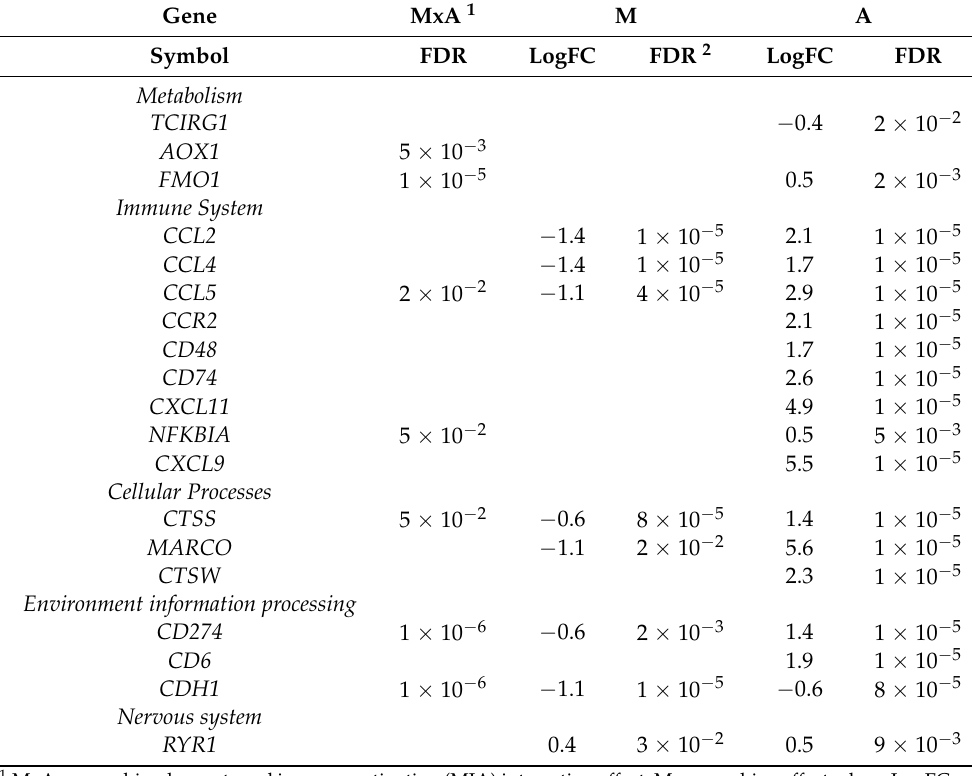
Table 3. Log2(fold change) and False Discovery Rate-adjusted p -value (LogFC and FDR, respectively) of the genes in the prefrontal cortex that presented a significant (FDR < 0.05) interaction or main effect of morphine (M) and maternal immune activation (A) and represent the pathways enriched at FDR < 0.05 and a normalized enrichment score |NES| >